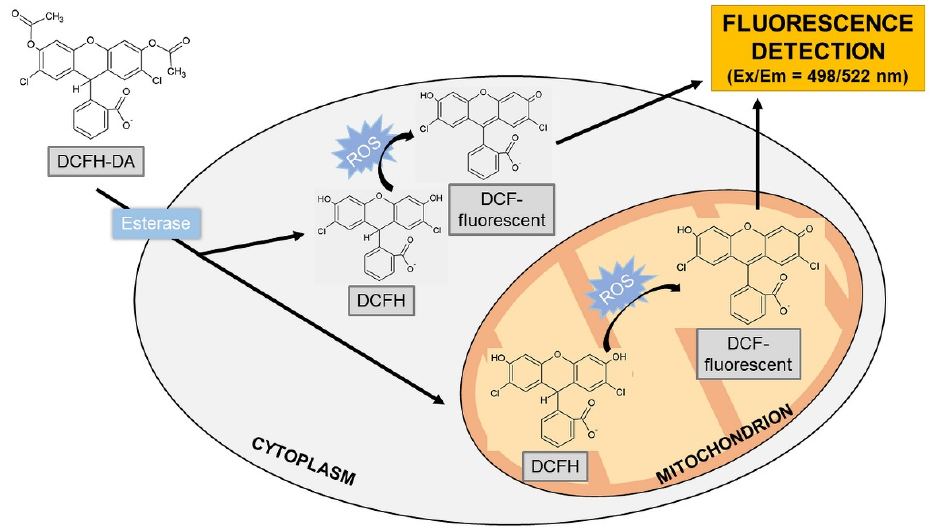
Figure 4. Detection of hydrogen peroxide using a probe DCFH-DA. Abbreviations: DCFH-DA = Figure 2´,7´-dichlorodihydrofluorescein diacetate; DCFH = 2´,7´-dichlorodihydrofluorescein; DCF = 2´,7´- dichlorofluorescein; and ROS = reactive oxygen species.